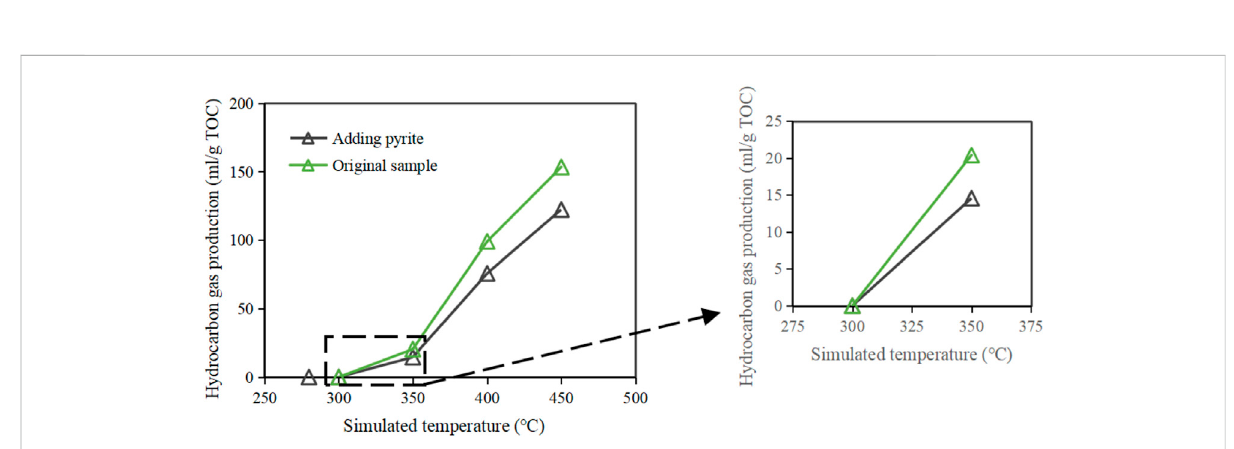
FIGURE 5 Comparison of gas generation potential before and after adding pyrite to the Chang 7 Member